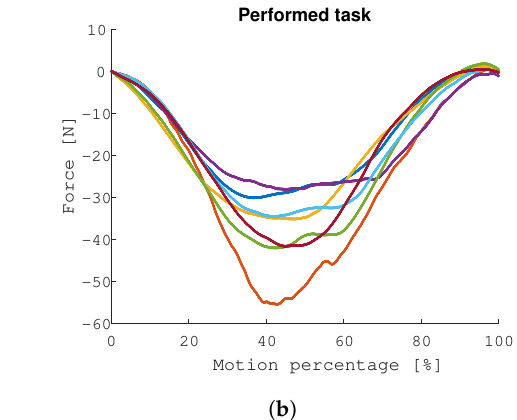
Figure 10. Human-in-the-loop calibration results: motion and forces measured at the end-effector. The trajectories and forces vary significantly across subjects. ( a ) The average motion for each participant of the end-effector of the robot during the experiment. ( b ) Average force for each participant of the end-effector of the robot during the